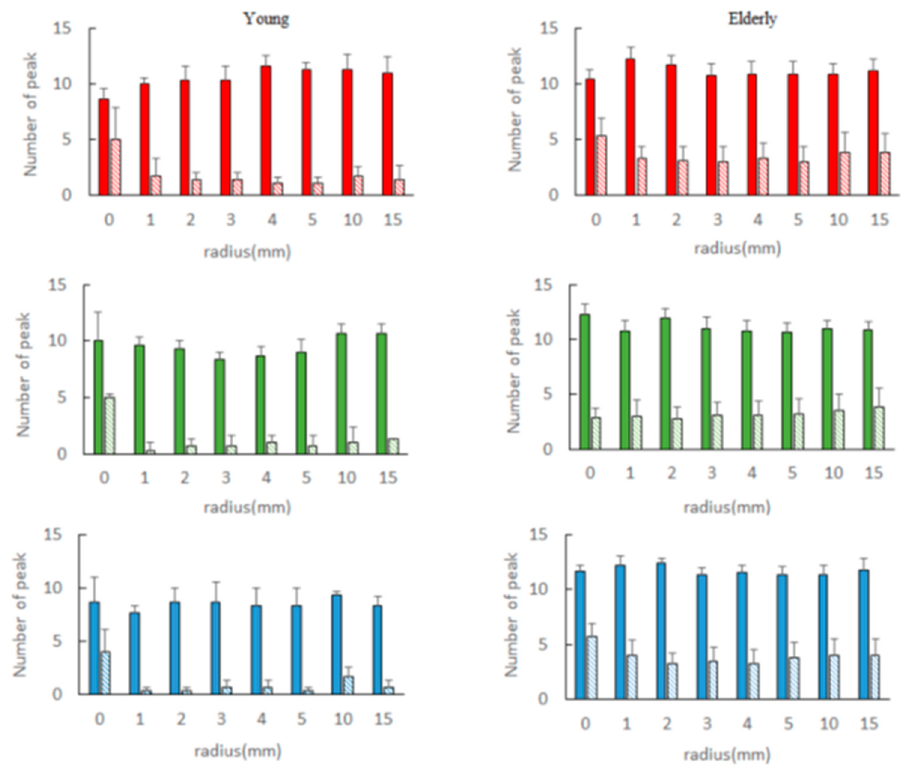
Figure 10. Number of different peak frequency for each radius. Left: young ( n = 3), right: elderly ( n = 8) solid: low frequency band, fine dotted: high frequency band, upper red power, middle green power, lower blue power, mean ± S.E.